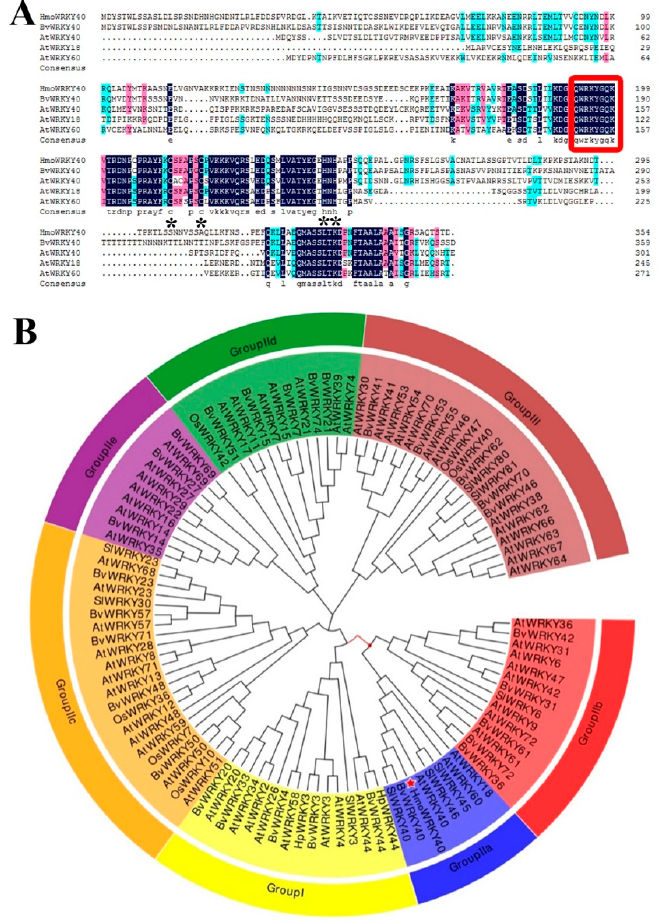
Figure 2. Bioinformatic analyses of HmoWRKY40: ( A ) Multiple alignment of HmoWRKY40 with the other plant WRKYs. The same and similar amino acids are indicated by blue and red shades, respectively. The WRKY motif and the zinc-finger structure are indicated by the red box and the black asterisks, respectively, and ( B ) The phylogenetic tree of HmoWRKY40 and WRKYs from Arabidopsis thaliana , Oryza sativa , Beta vulgaris and Solanum lycopersicum . HmoWRKY40 protein is indicated by a red asterisk. The phylogenetic tree was constructed using the maximum likelihood method by MEGA7.0.